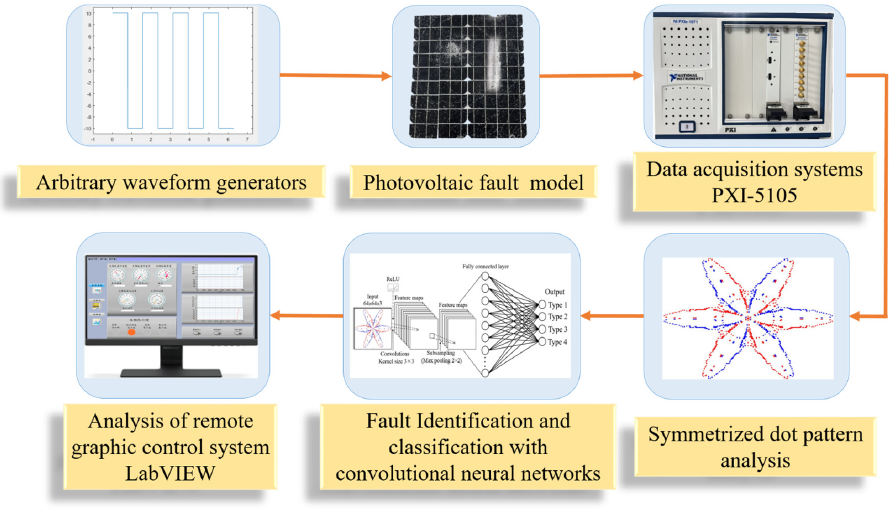
Figure 1. The overall system detection process architecture.